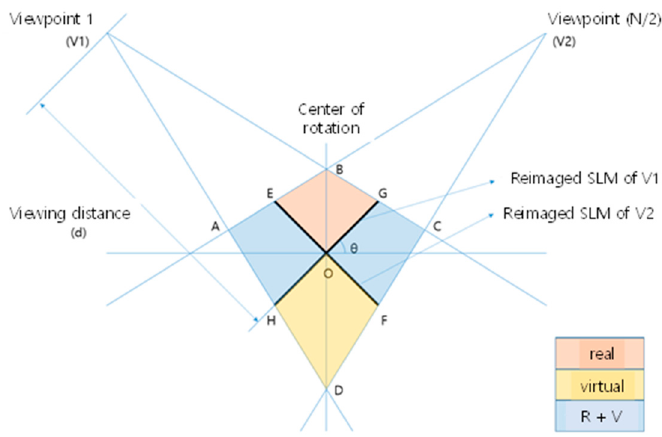
Figure 10. Image volume space.